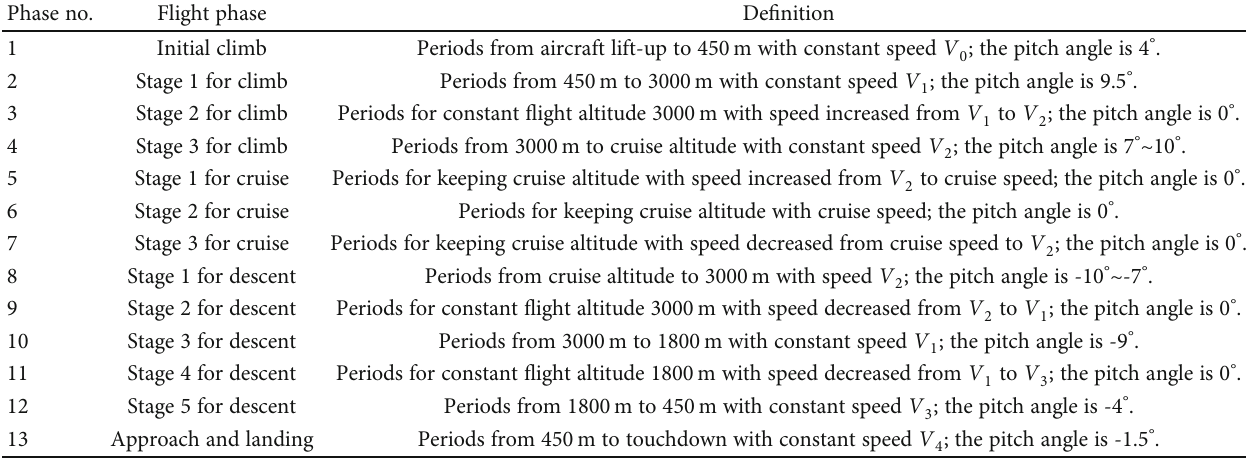
Table 1: De fi nition of the fl ight phases.